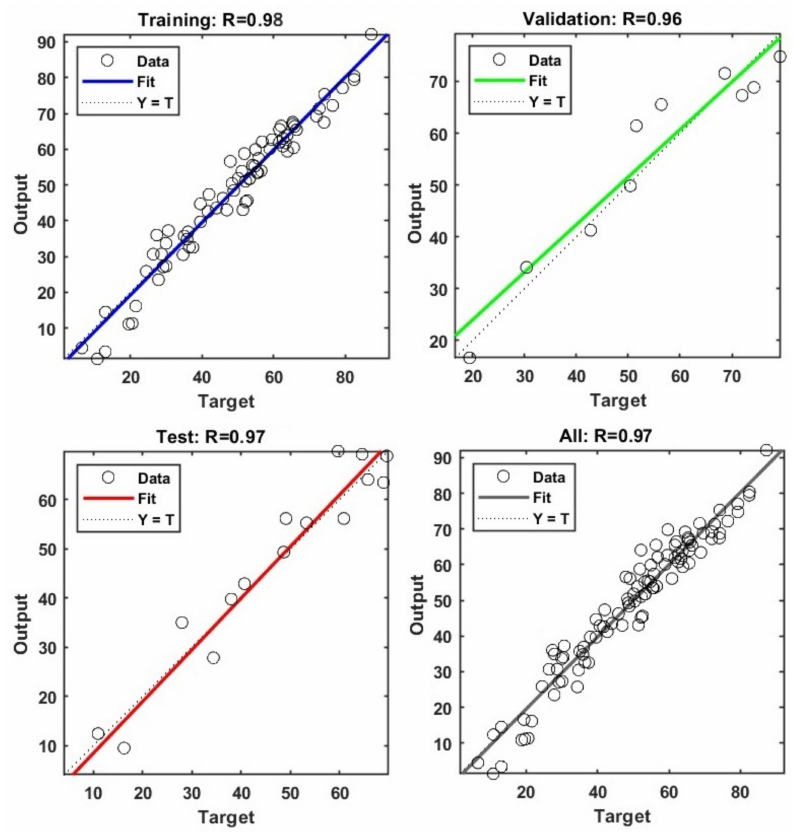
Figure 14. The regression plot of the data used in the training, validation and testing